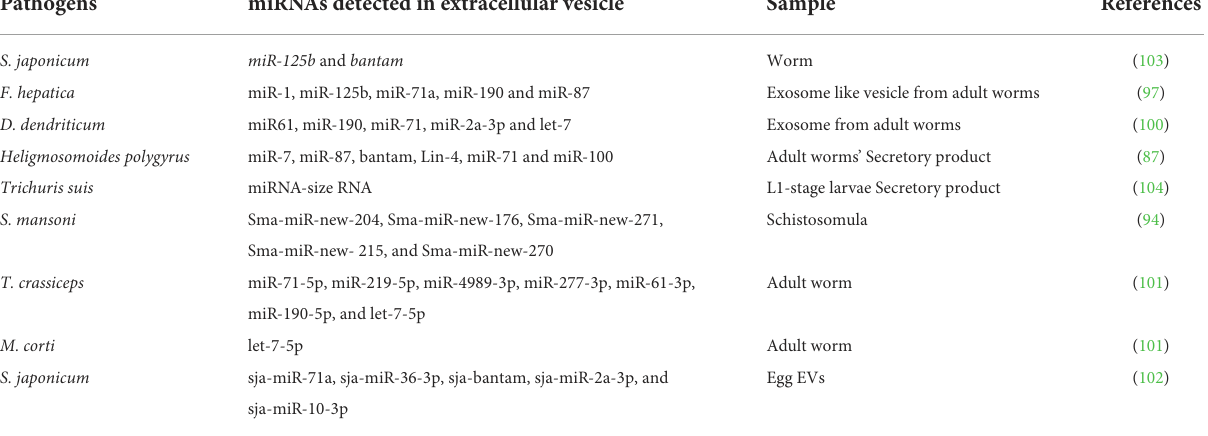
TABLE 2 MicroRNA detect from extracellular